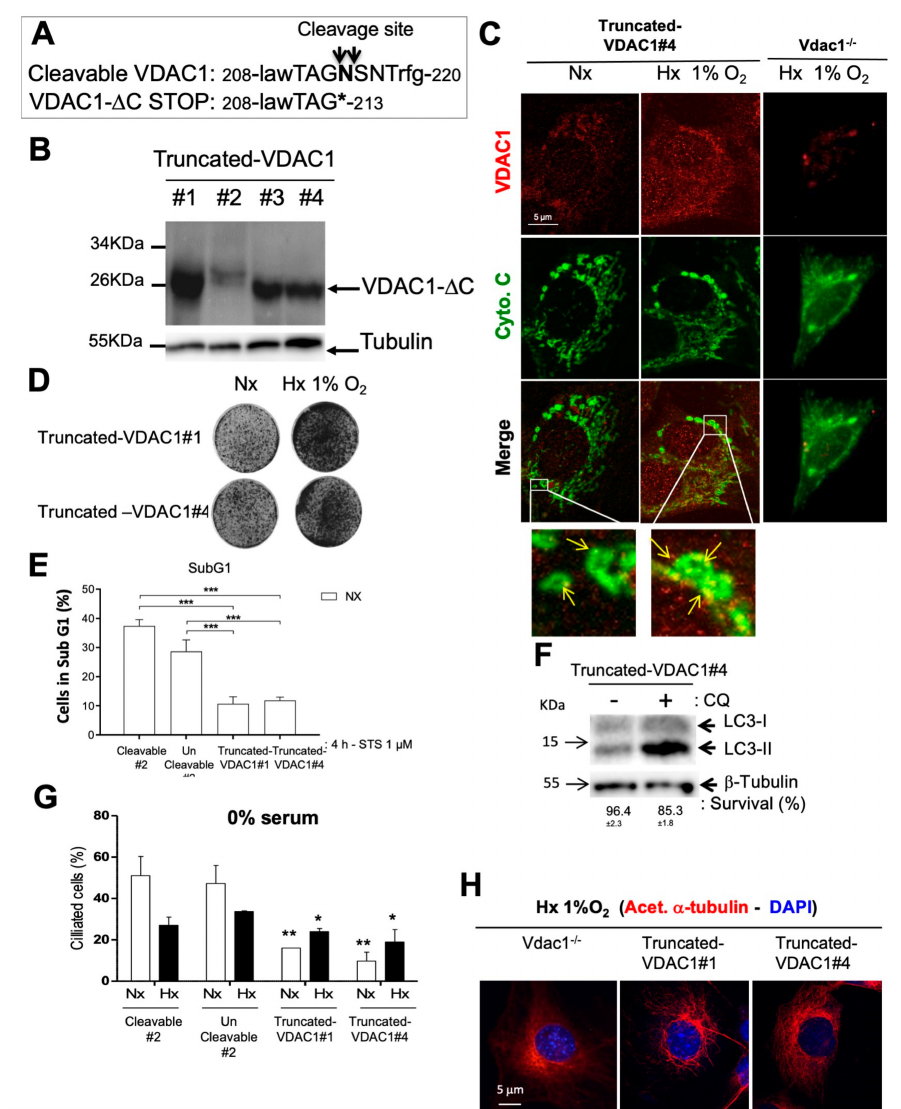
Figure 5. VDAC1- ∆ C has a direct impact on cell death and primary cilium formation. ( A ) Schematic representation of mutations made at the cleavage site of VDAC1 to create a STOP Amber mutation. ( B )Truncated-VDAC1#1 / #2 / #3 / #4cellswereincubatedinnormoxiafor24handcelllysateswereanalyzed by immunoblotting for VDAC1. β -tubulin was used as a loading control. ( C ) Immunofluorescence to VDAC1 and cytochrome c (Cyto.C) in Truncated-VDAC1#4 cells in Nx and Hx 1% O2 and Vdac1 − / − cells in Hx 1% O 2 for 72 h. ( D ) Clonogenic assay of Truncated-VDAC1#1 and #4 cells. Cell lines were seeded at the same density and incubated in Nx or Hx 1% O 2 for 10 days. ( E ) Cleavable#2, Truncated-VDAC1#1 / #4 cells were incubated in Nx or Hx 1% O 2 for 72 h and challenged with staurosporin (STS) (1 µ M) for 4 h. Cell mortality was measured using an ADAM cell counter. ( F ) Truncated-VADC1#4 cells were incubated in Nx in the absence ( − ) or presence ( + ) of chloroquine (CQ) and cell lysates were analyzed by immunoblotting for LC3-I / II. β -tubulin was used as a loading control. Cell viability was measured using an ADAM cell counter. ( G ) Quantitative analysis of the e ff ect of Nx and Hx 1% O2 for 72 h on the ciliation percentage in the absence of serum (0% serum) in Cleavable#2, UnCleavable#2 and Truncated-VDAC1#1 / #4 cells assessed by confocal fluorescence microscopy ( n = 100–300 cells). ( H ) Immunofluorescence to acetylated α -tubulin (acet. α -tubulin in red) and DAPI (in blue) in Truncated-VDAC1#1 and Truncated-VDAC1#4 cells in Hx 1% O 2 for 72 h. * indicates p < 0.05 and ** indicates p < 0.005. The uncropped Western Blot figures in Figure